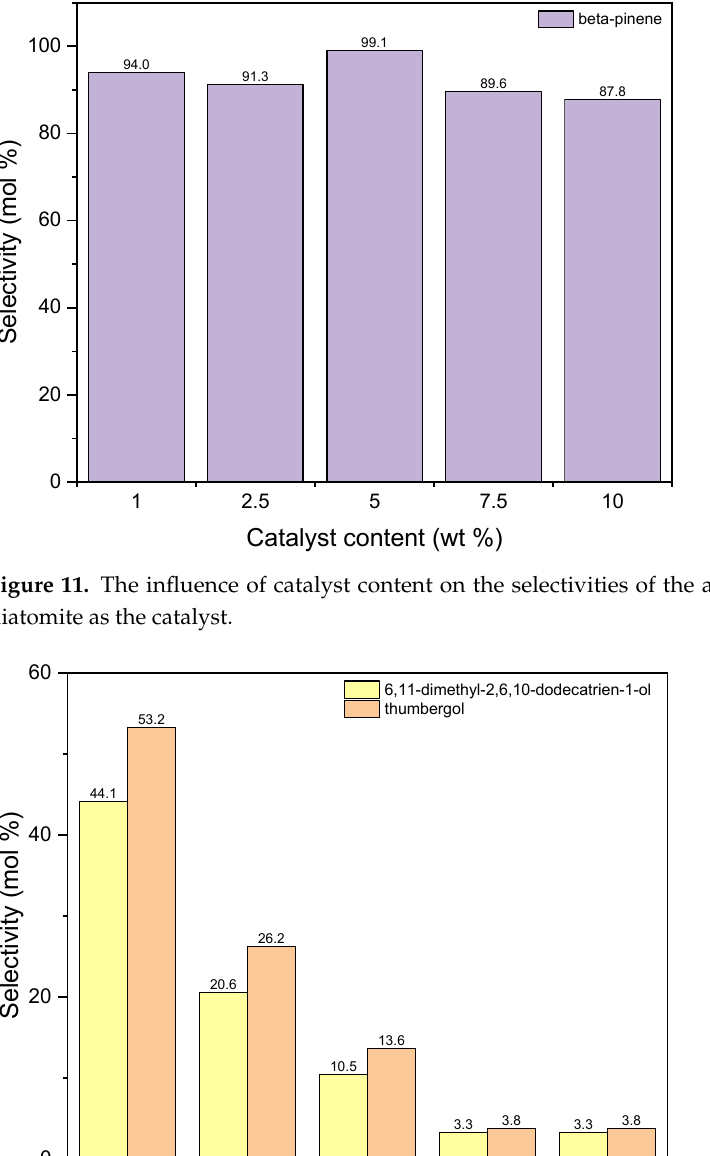
Figure 12. The influence of catalyst content on the selectivities of the appropriate products over aluminium potassium alum as the catalyst. aluminium potassium alum as the